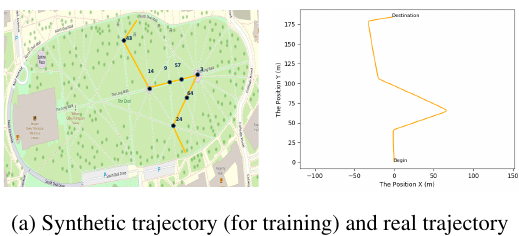
(a) Synthetic trajectory (for training) and real trajectory from VO (for testing).